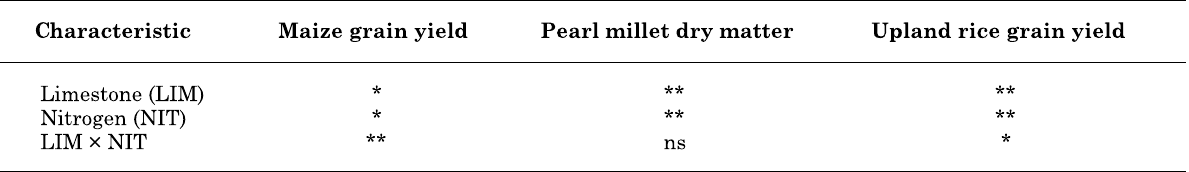
Table 1. ANOVA significance of maize grain yield, pearl millet dry matter and upland rice grain yield results as affected by nitrogen fertilization and liming at Botucatu, São Paulo, Brazil